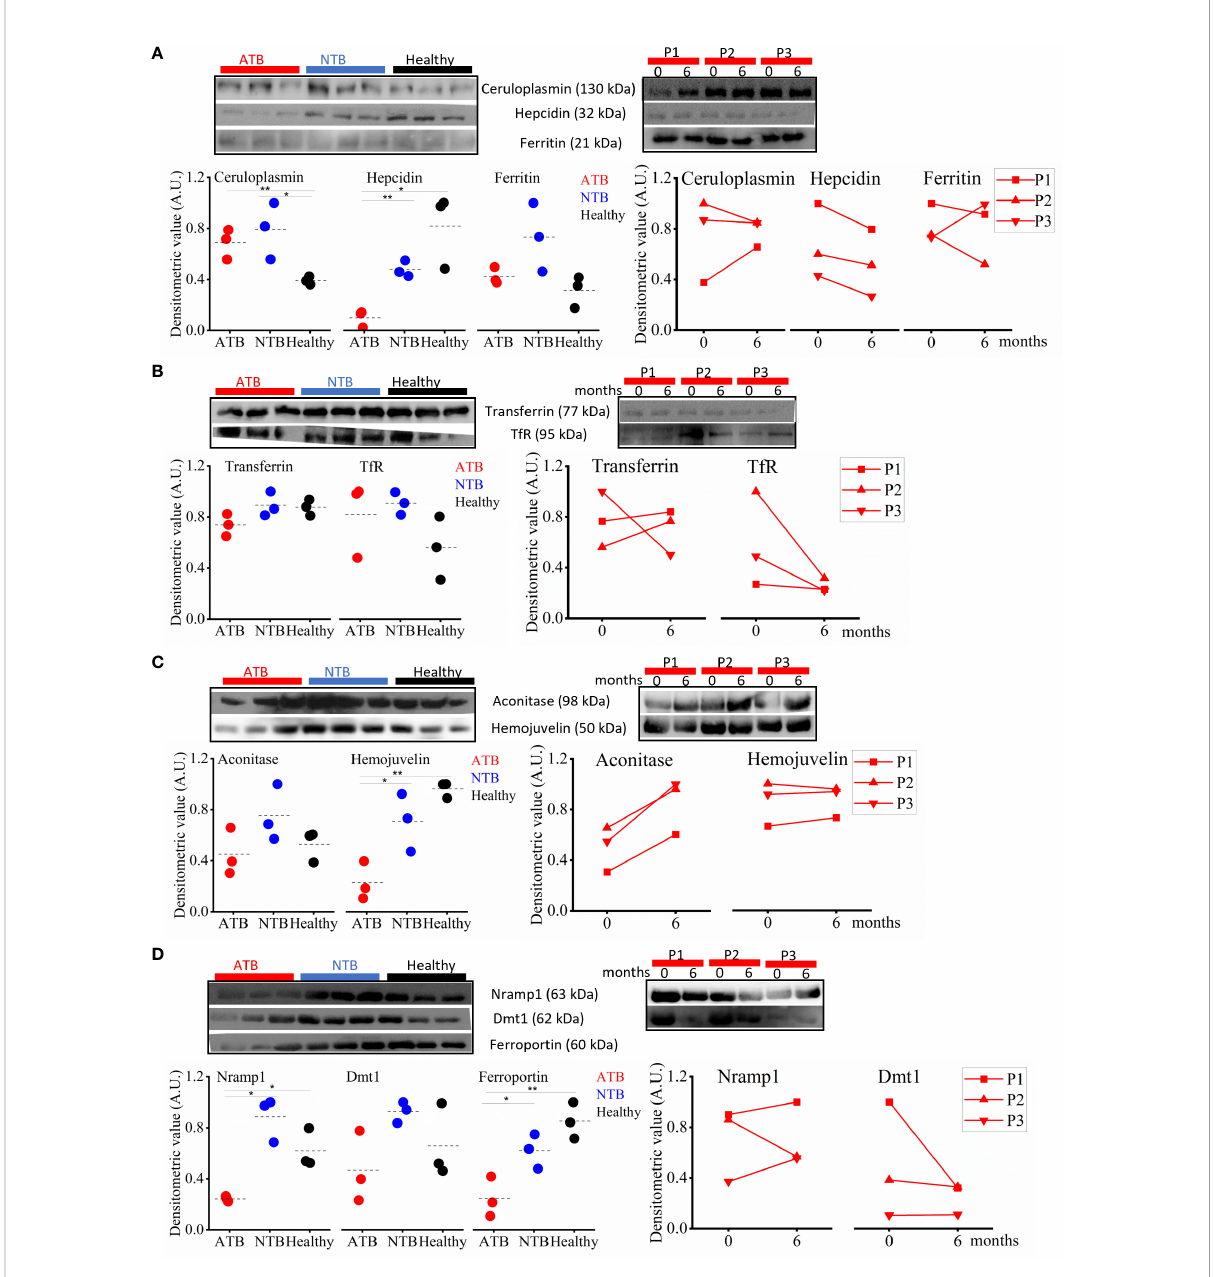
FIGURE 6 Perturbed iron homeostasis indicating iron sequestration observed in active tuberculosis (ATB) patients. Western blot images and densitometric value expression in ATB, non-tuberculosis (NTB), and healthy controls and in longitudinally followed up tuberculosis patients at case presentation (0 months) and upon completion of treatment (6 months) in in fl ammatory marker proteins (ceruloplasmin, ferritin, and hepcidin) (A) , iron carrier proteins (transferrin and TfR) (B) , iron-sensing proteins (hemojuvelin and IRP1) (C) , and iron transporter proteins (ferroportin1, Nramp1, and Dmt1) (D) (P, patient; TfR, Transferrin receptor; IRP1, Iron regulatory protein 1; Nramp1, Natural resistance-associated macrophage protein 1; Dmt1, Divalent metal ion transporter 1; A.U., arbitrary unit; * p < 0.05; ** p <